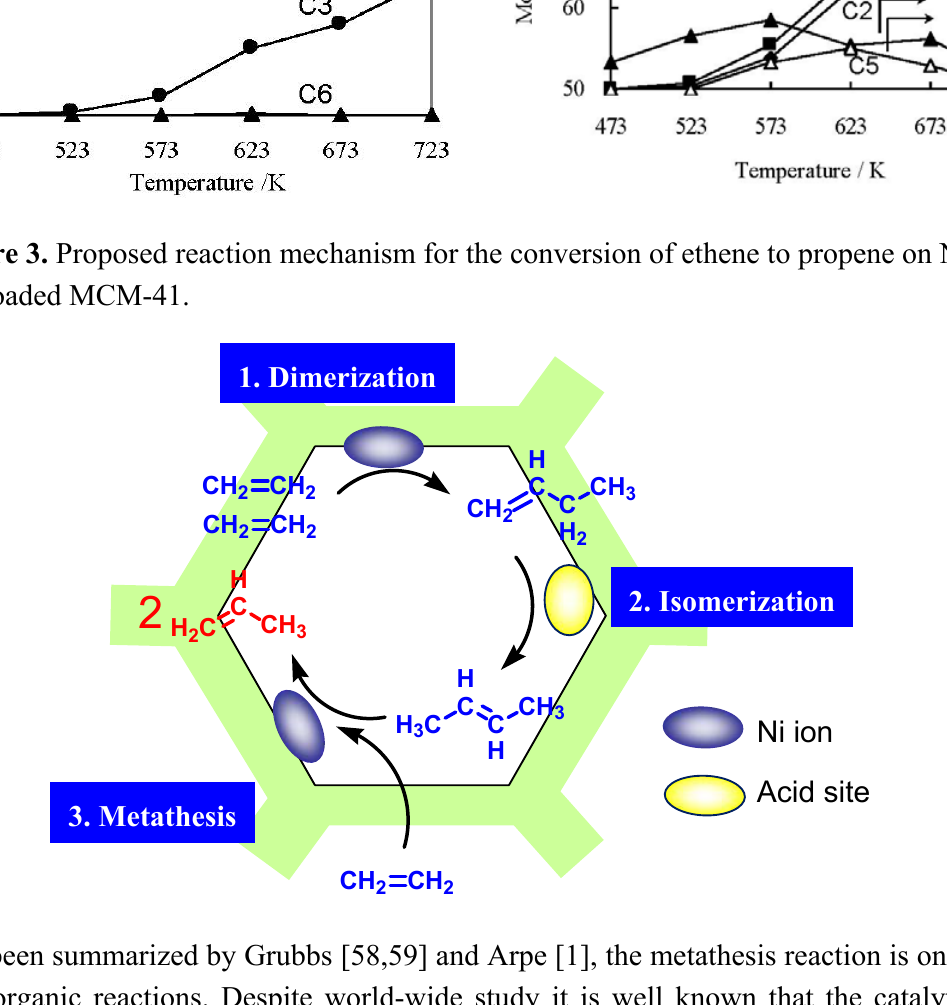
= P = 5%) or propene C2H4 C4H8